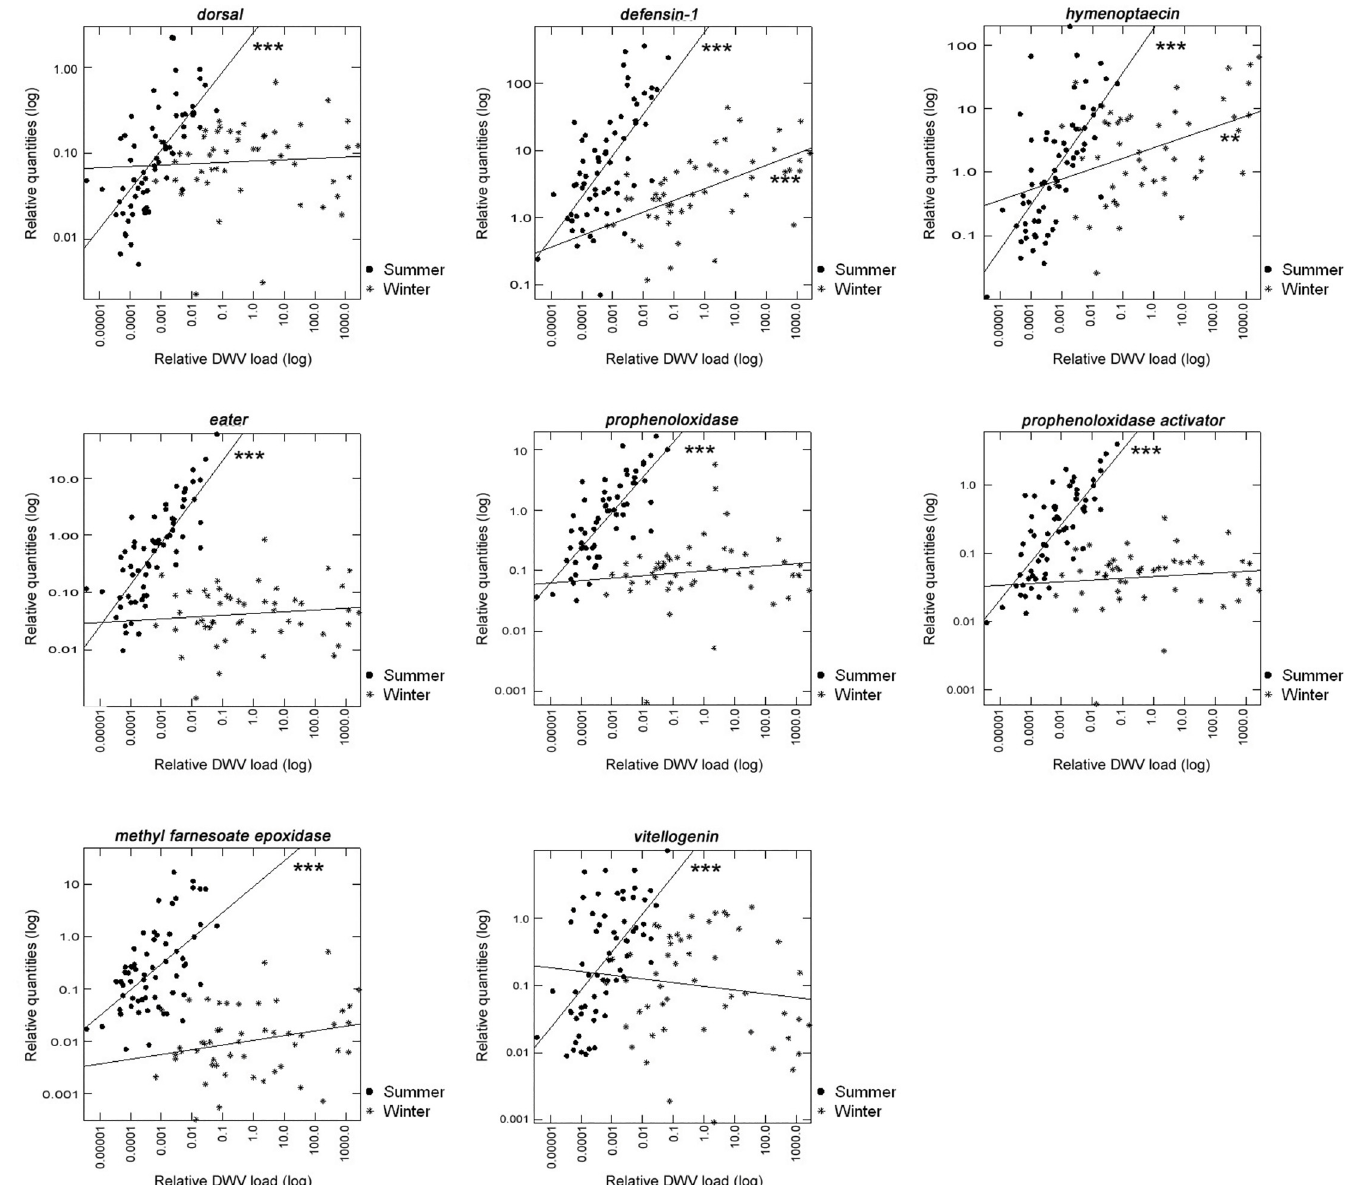
Fig 3. Correlations of relative gene expression to DWV load. Y-axis show relative quantities of gene expressions (log10). X-axis show relative DWV genome copies (log10). ( ● ) Summer (N = 67), ( * ) winter (N = 50). (Mann-Whitney test, ** P < 0.01; *** P <